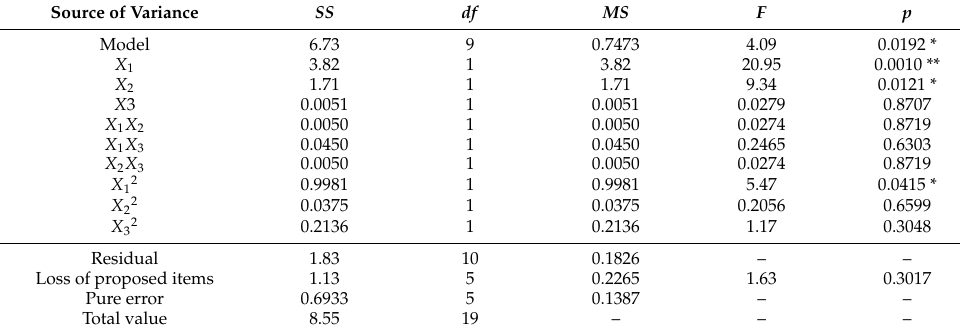
Table 4. Analysis of variance of the test factor on the CBG of